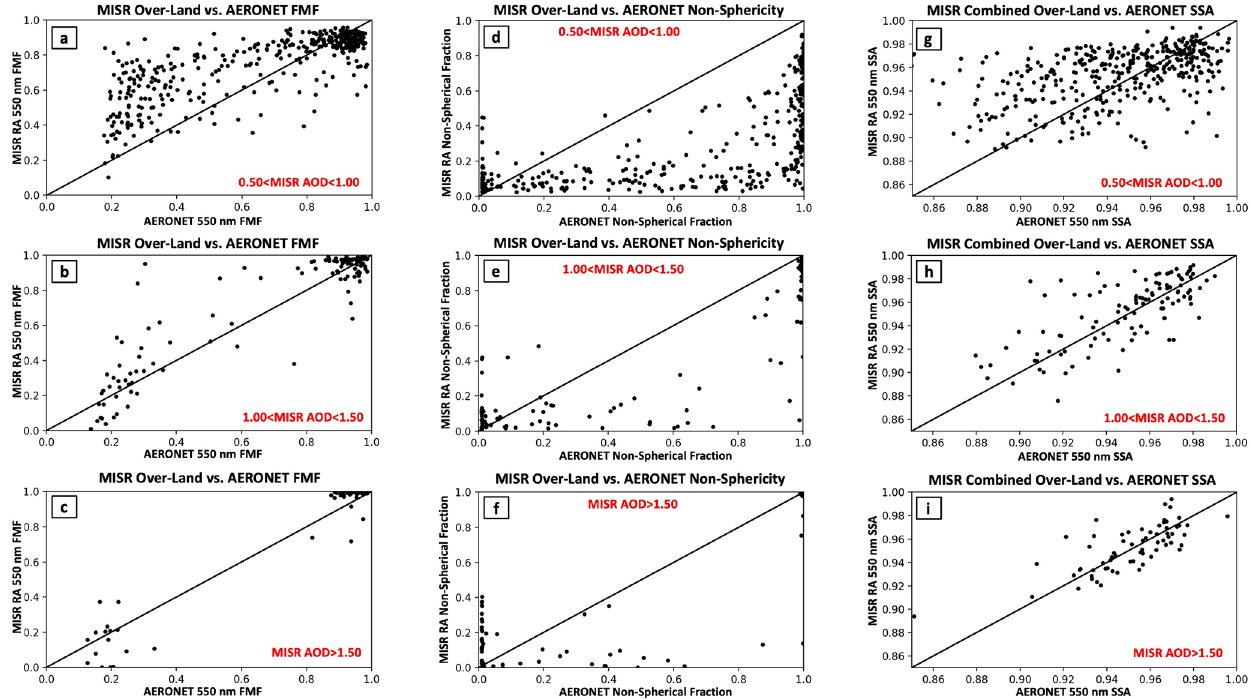
Figure 5. Scatterplots of the MISR RA combined surface algorithm over-land 550nm particle properties compared to AERONET 550nm retrieved particle properties. The x axes are AERONET 550nm particle properties and y axes are the MISR combined surface algorithm over-land 550nm particle properties. AOD constraints are embedded in red for each panel. The first row of panels (a, d, g) corresponds to retrievals with 0 . 50 < MISR AOD < 1. The second row of panels (b, e, h) corresponds to retrievals with 1 . 00 < MISR AOD < 1 . 50. The third row of panels (c, f, i) corresponds to retrievals with MISR AOD > 1 . 50. The first column of panels (a–c) shows MISR RA-retrieved fine- mode fraction (FMF) vs. AERONET-retrieved FMF, the second column of panels (d–f) shows MISR RA-retrieved non-spherical fraction vs. AERONET-retrieved non-spherical fraction, and the third column of panels (g–i) shows MISR RA-retrieved single-scattering albedo (SSA) vs. AERONET-retrieved